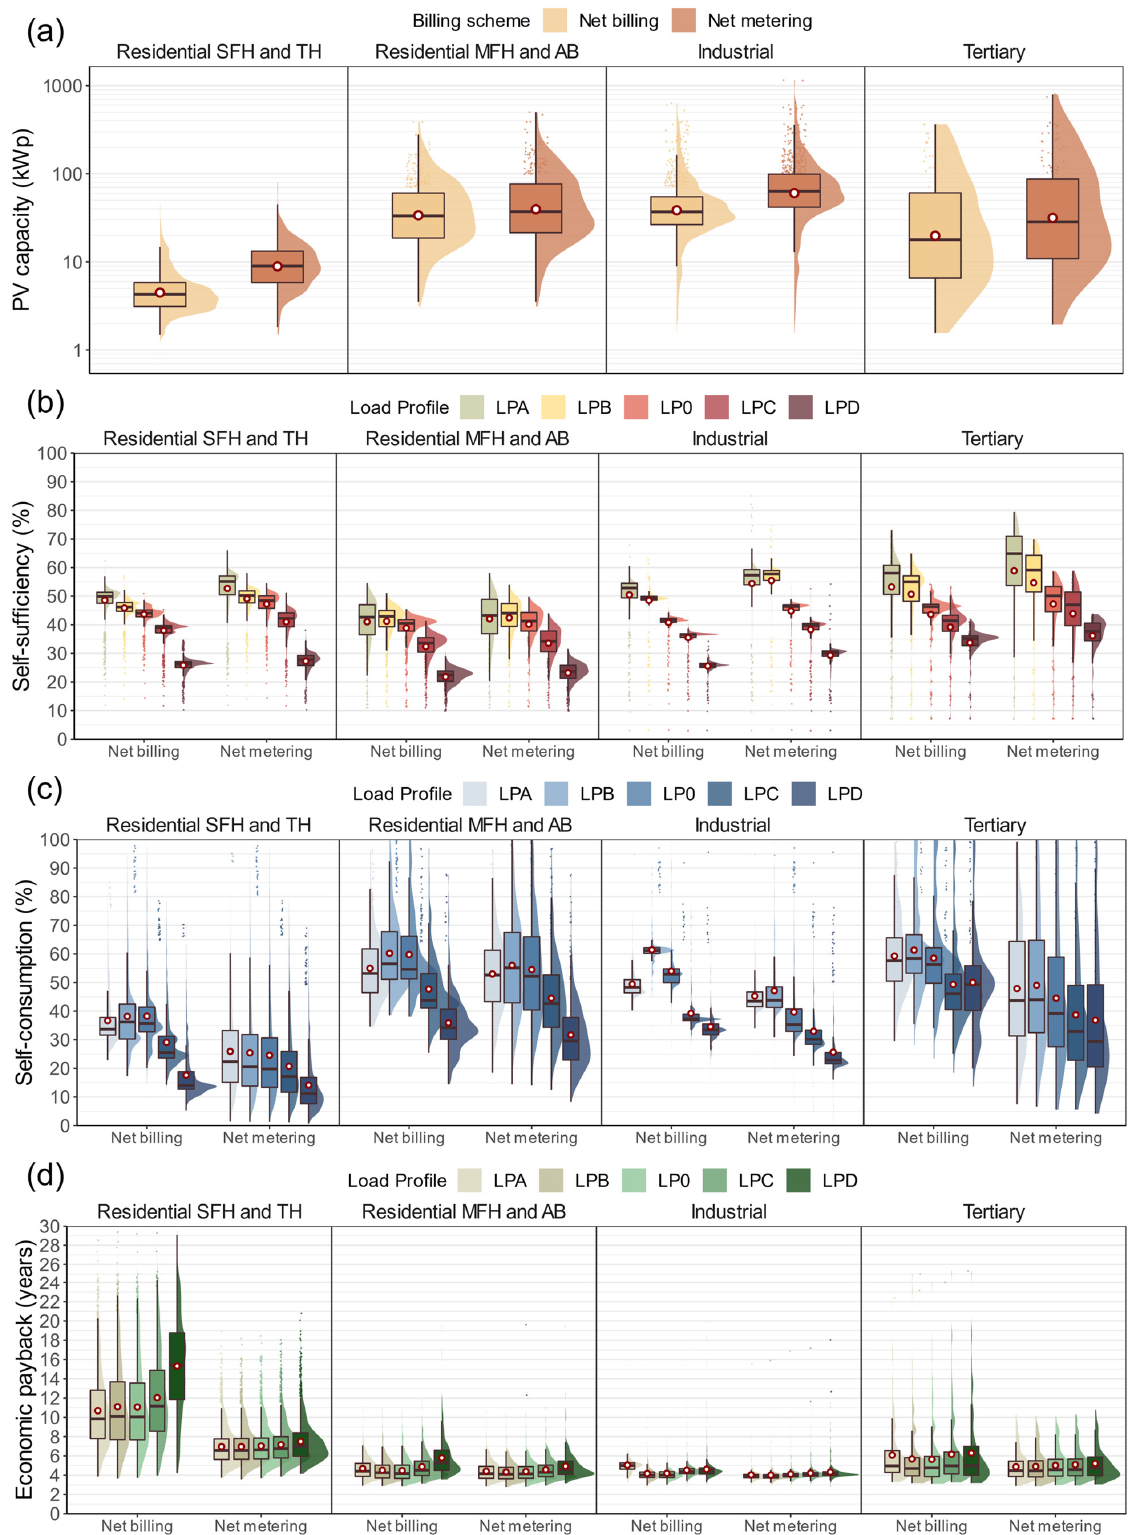
Figure 5. Boxplots of ( a ) optimal capacity of the facilities for the base scenario, and ( b ) SS , ( c ) SC and ( d ) PB for the di ff erent building typologies and load pro fi les scenarios.